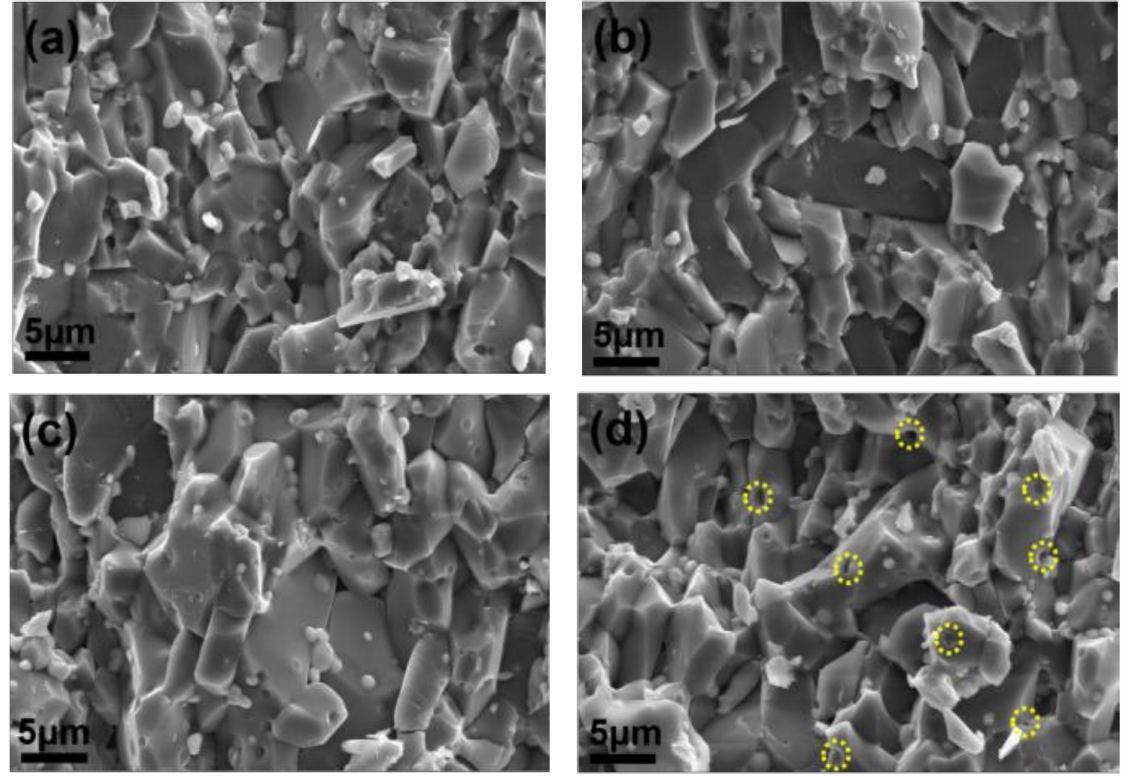
Figure 5. SEM images of fracture surface, ( a , b ) A2; ( c , d )